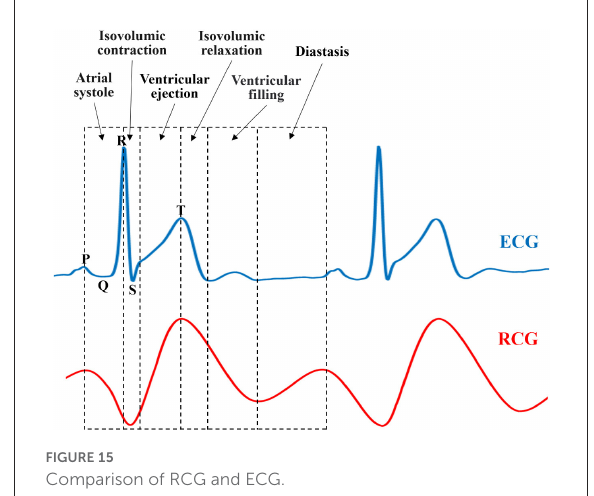
FIGURE15 Comparison of RCG and